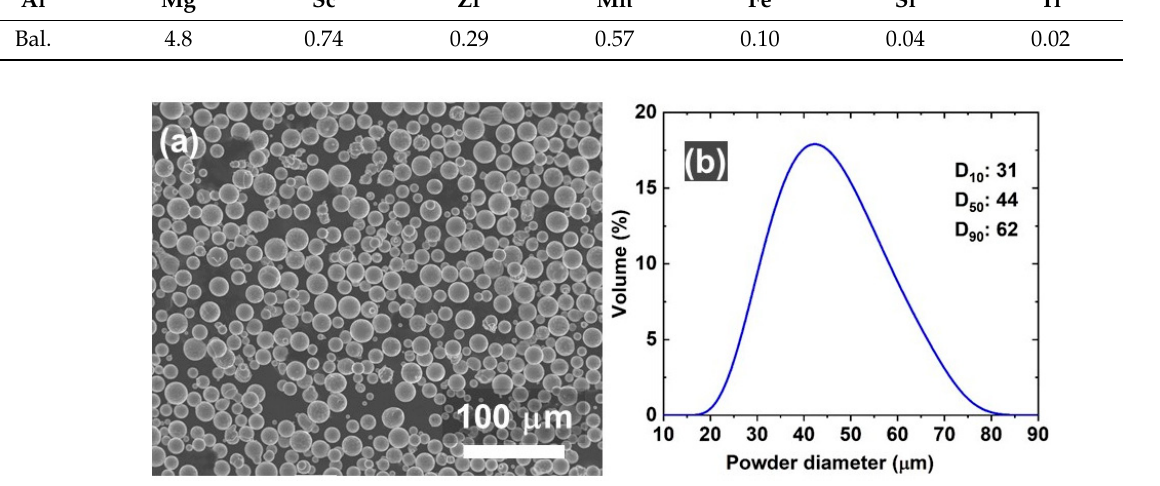
Figure 1. ( a ) Morphology of the Scalmalloy powders used in LPBF, and ( b ) powder size distribution. An LPBF machine (EOS M290, Munich, Germany) with a 400 W Yb-fiber laser